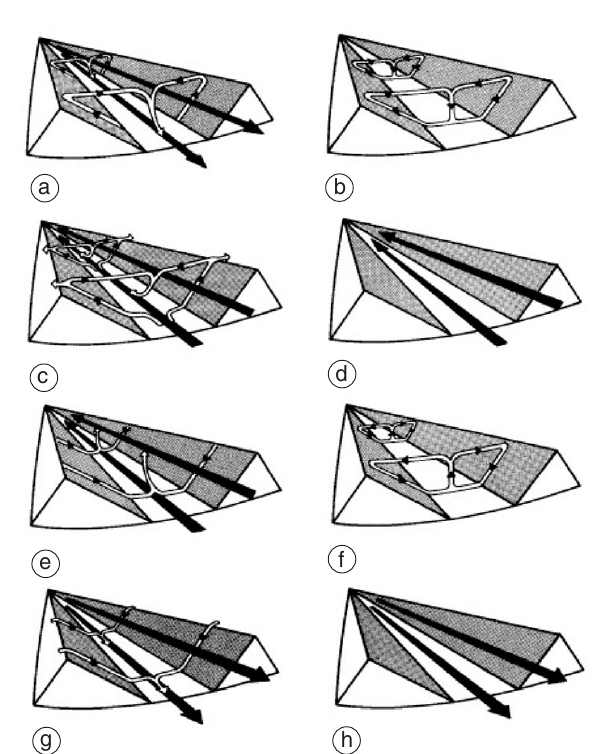
Fig. 1a-h. Diurnal cycle of valley winds (after De- fant, 1949): a) Sunrise: onset of up-slope winds (white arrows), continuation of mountain wind (black